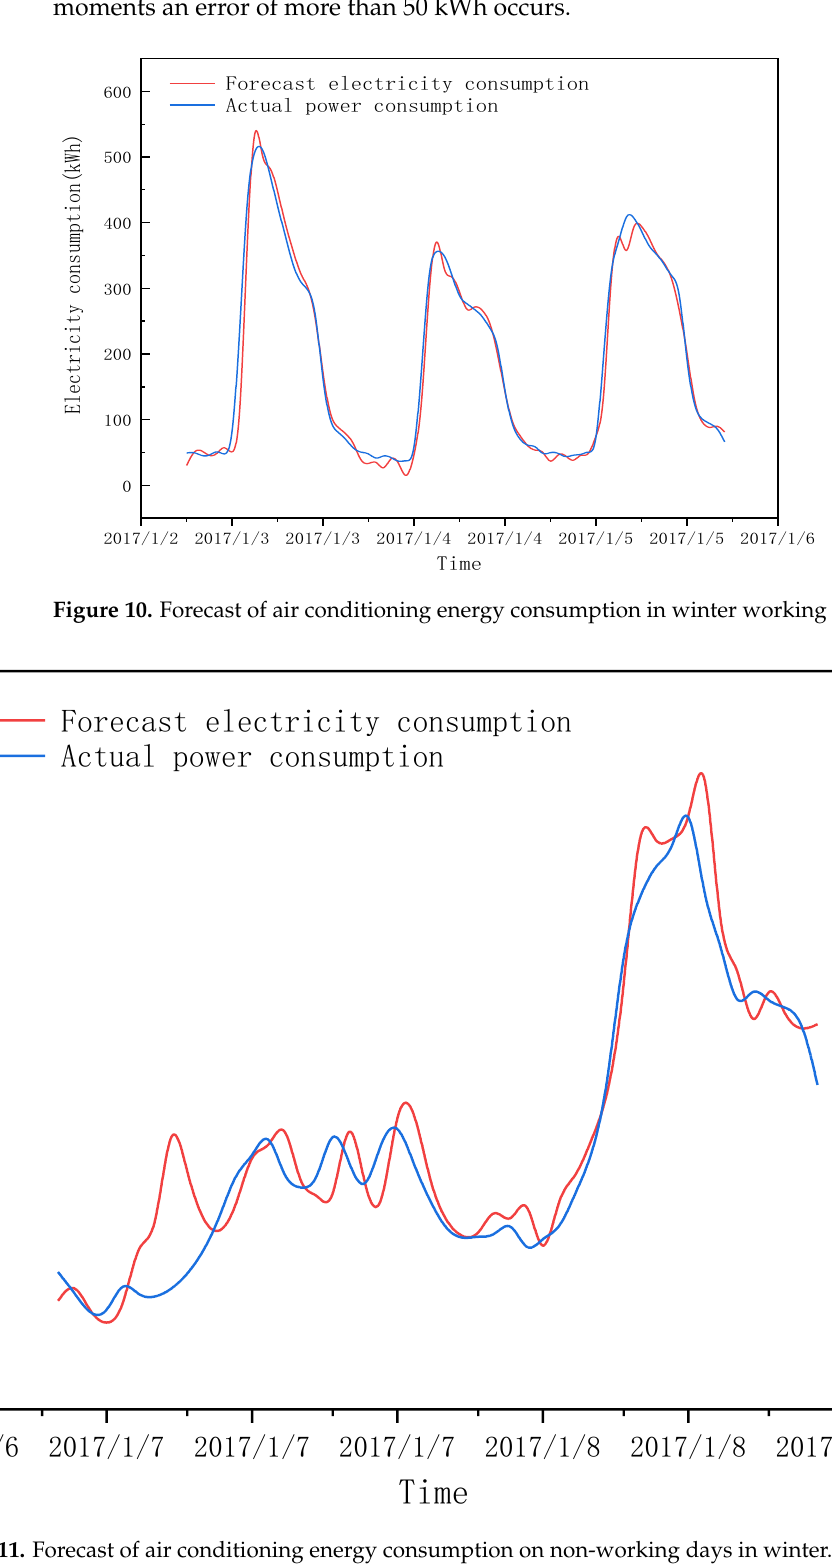
Figure 9. Forecast of air conditioning power consumption in summer 2017.